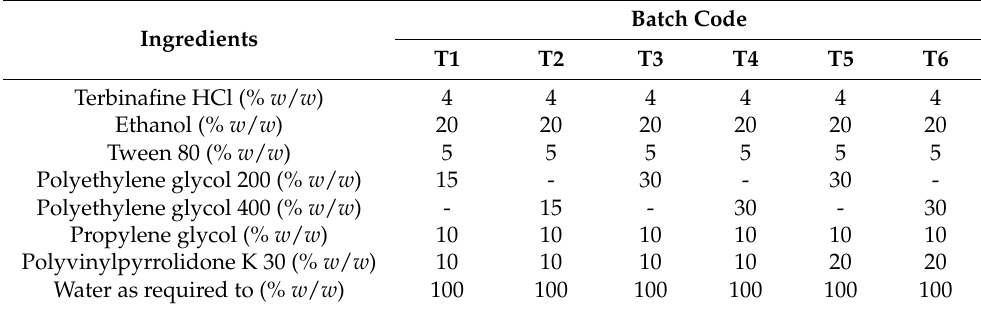
Table 1. Composition of preliminary batches (T1–T6) of